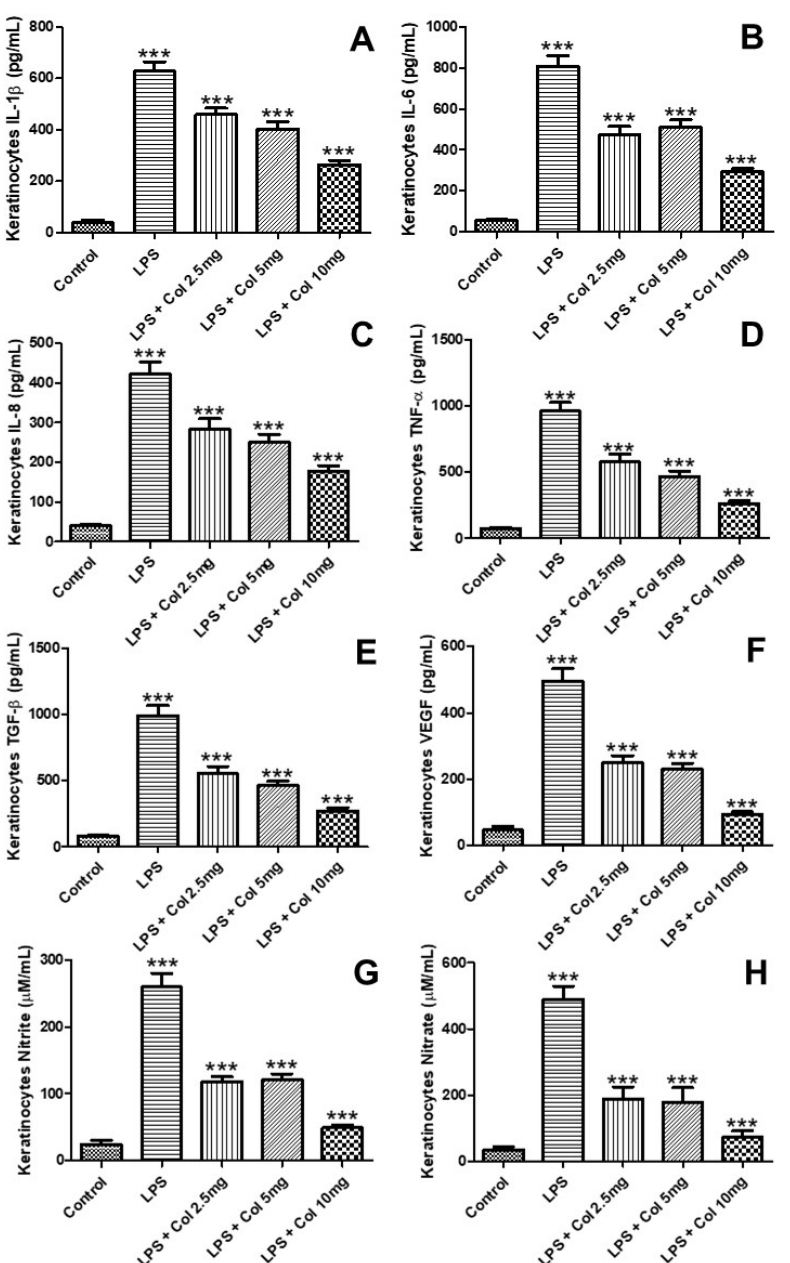
Figure 6. The figure shows the effects of collagen supplementation on the levels of IL-1 β ( A ), IL-6 ( B ), IL-8 ( C ), TNF- α ( D ), TGF- β ( E ), VEGF ( F ), nitrite ( G ), and nitrate ( H ) of human keratinocytes. For ( A – H ), *** p < 0.001 compared with the control group and LPS